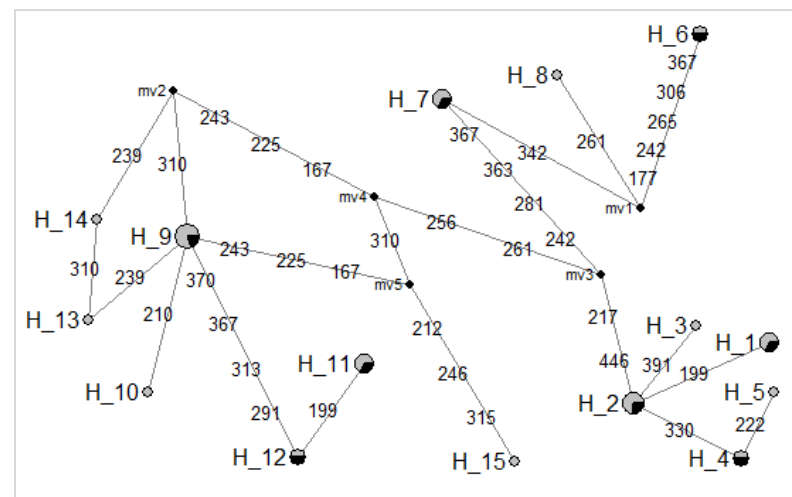
Figure 1. Network profiles of the 15 haplotypes from the six Korean native chicken populations. The links are labeled by the nucleotide positions. The order of the mutations on the branch is arbitrary. The median vectors (mv) are nucleotide